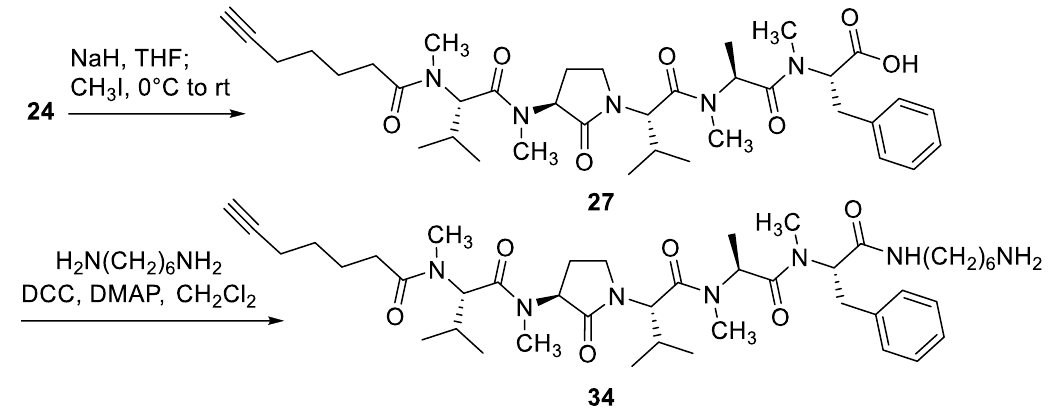
Scheme 2. Representative permethylation of peptide acid 24 and coupling to 1,6-diaminohexane to prepare peptide amide 34